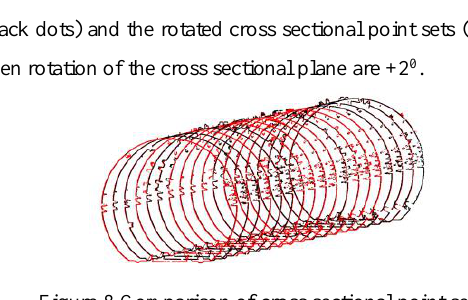
Figure 8 Comparison of cross sectional point sets